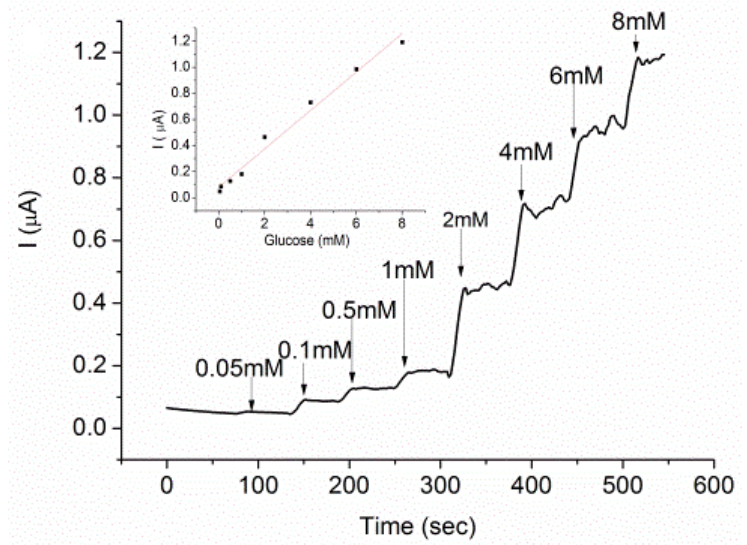
Figure 6. Amperometric response of the GC/AuNPs/GOx modified upon successive addition of glucose at the potential of 0.6 V. Inset, current change vs. glucose concentration curve.